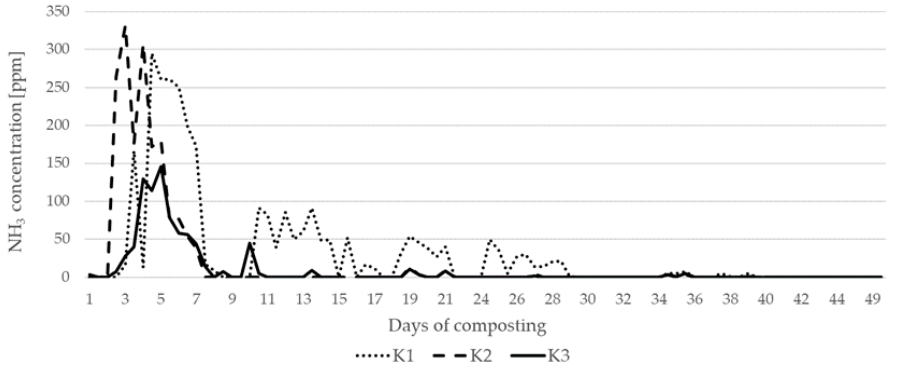
Figure 7. The ammonia concentration in the exhausted gas in the analyzed